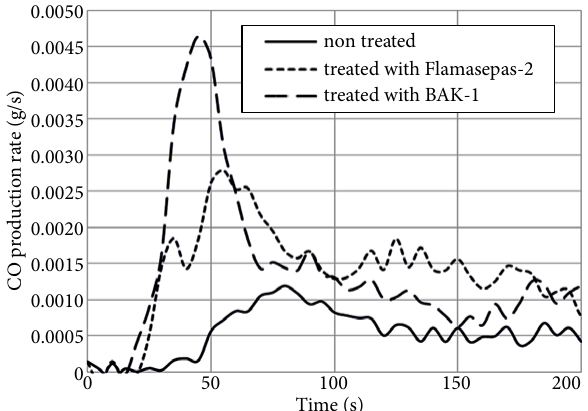
Fig. 10. The extinction coefficient obtained during the combustion of non-treated and treated specimens in the cone calorimeter at the heat flux of 30 kW/m 2 (with piloted